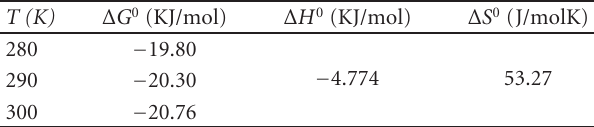
Table 4: The free energy change Δ G 0 , enthalpy change Δ H 0 and entropy change Δ S 0 for electrical removal of CNT-CNF film electrodes in CuCl 2